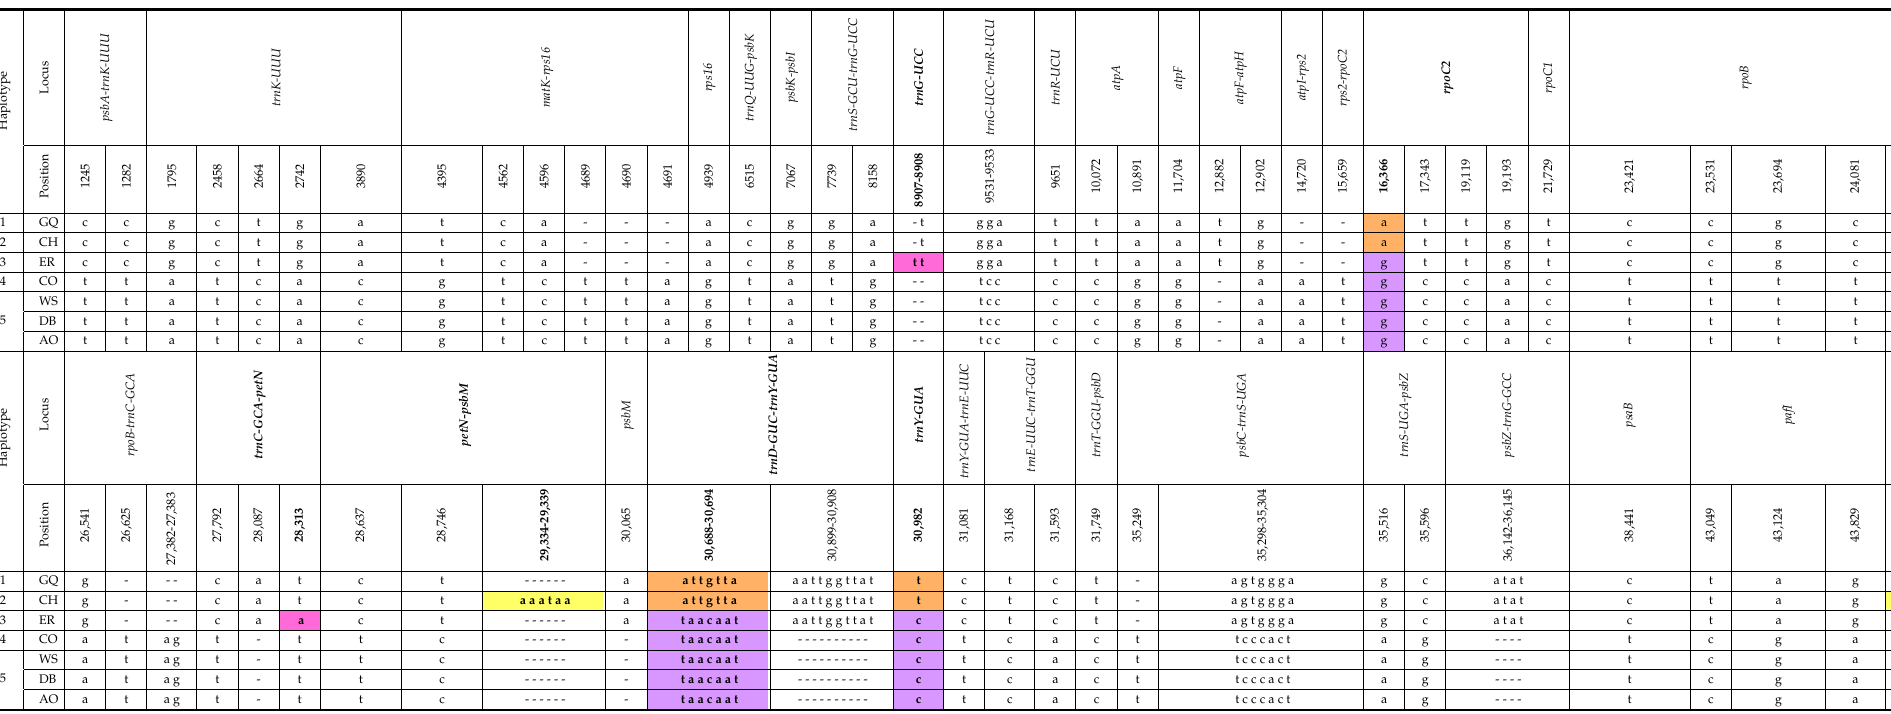
Table 4. Variable sites of the seven Hyacinthus